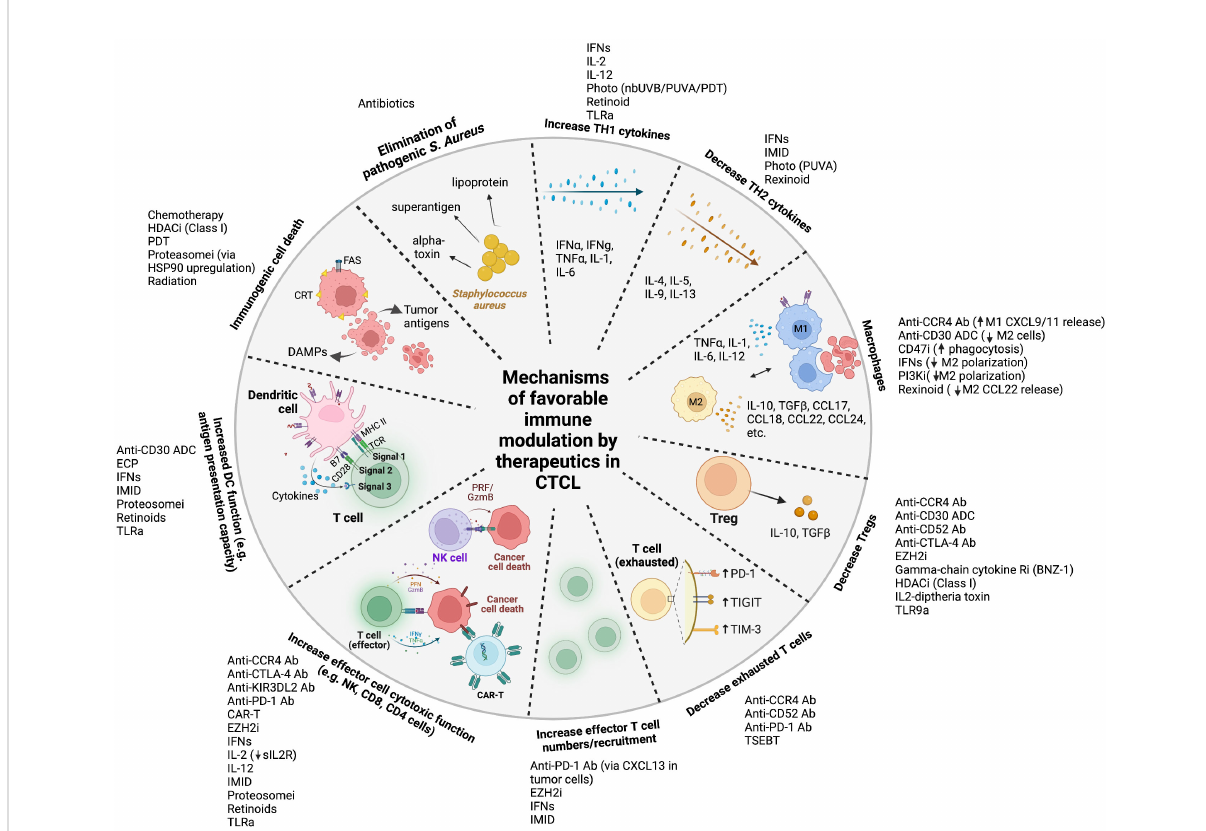
FIGURE 1 Mechanisms of favorable immune modulation by therapeutics in cutaneous T cell lymphoma Legend: ab, antibody; ADC, antibody-drug conjugate; anti-CTLA-4, anti-cytotoxic T-lymphocyte-associated protein 4; anti-PD-1, anti-programmed cell death protein 1; CAR, chimeric antigen receptor; CCR4, anti-C-C chemokine receptor 4; CD47i, cluster of differentiation 47 inhibitor; CRT, calreticulin; DAMPs, damage associated molecular patterns DC, dendritic cell; ECP, extracorporeal photopheresis; EZH2i, enhancer of zeste homolog 2 inhibitor; GzmB, granzyme B; HDACi, histone deacetylase inhibitor; IFNs, interferons; IL, interleukin; IMID, immunomodulator (lenalidomide); MHC, major histocompatibility complex; nbUVB, narrowband ultraviolet B; NK, natural killer; PI3Ki, phosphoinositide 3-kinase inhibitor; PRF, perforin; proteosomei, proteosome inhibitor; PUVA, psoralen plus ultraviolet A; sIL2R, soluble interleukin-2 receptor; TCR, T cell receptor; TGF, transforming growth factor; T h 1, Type 1 T helper; T h 2, Type 2 T helper; TIGIT, T cell immunoreceptor with Ig and ITIM domains; TIM-3, T cell immunoglobulin and mucin-domain containing-3; TLRa, toll like receptor agonist; TNF, tumor necrosis factor; TSEBT, total skin electron beam